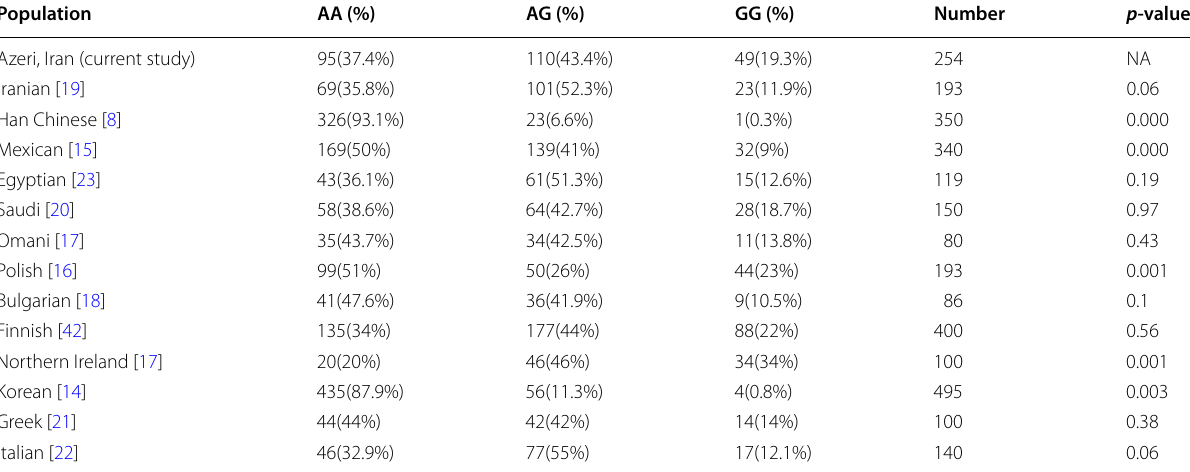
Table 2 Frequency of IL-10 genotypes -1082 in healthy populations from various populations